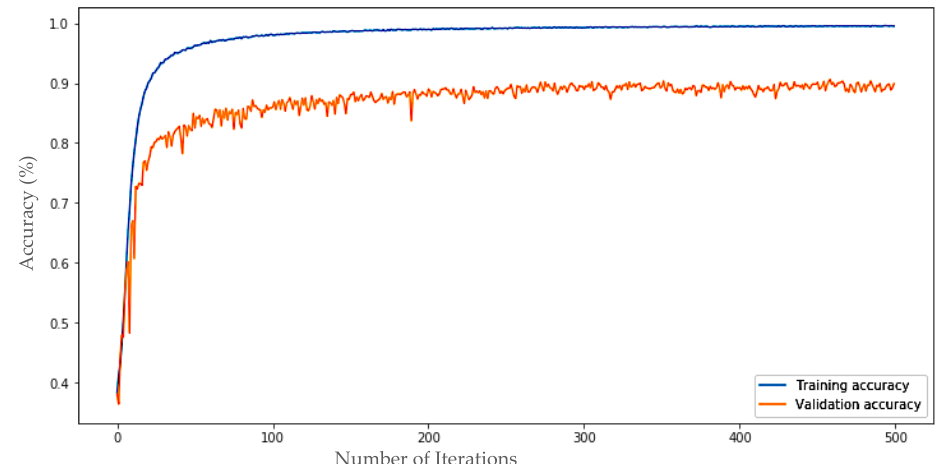
Figure 10. The proposed network accuracy for three-class scenarios for F3 and C3 channels.